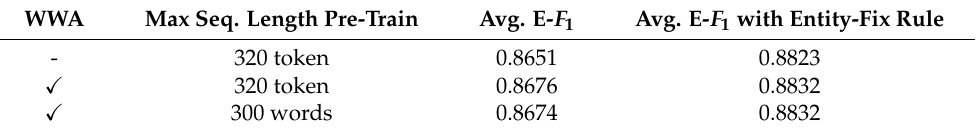
Table 9. Average E- F 1 score of three fine-tuning runs with LCRF NER on BERTs pre-trained with Mask